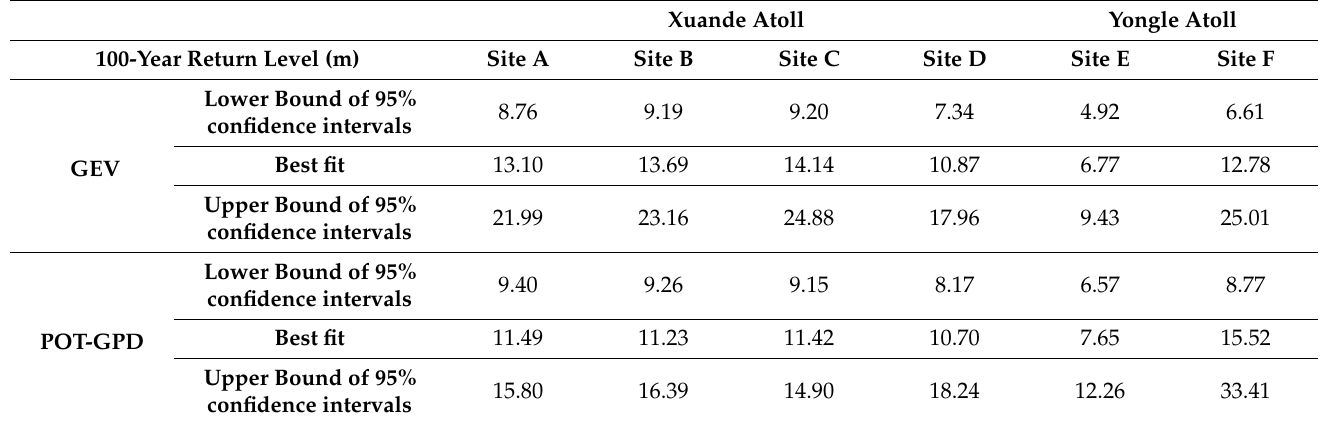
Table 4. Hundred-year return level estimation results at six sites.